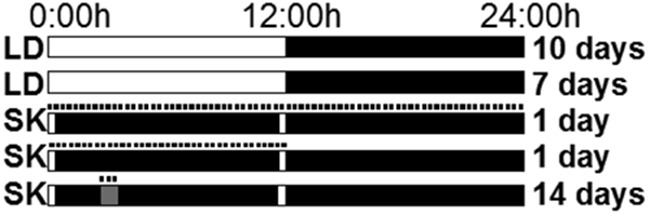

Schematic depicting experimental design. Mice were group-caged for 10 d and then housed singly for 7 d. The LD cycle (white bar = lights on, black bar = lights off) was used for the first 17 d to establish entrainment. For the remainder of the study, a skeleton photoperiod was used (lights on ZT0–ZT0:30 and ZT11:30–ZT12:00) to maintain entrainment. MA or W was nebulized in the chamber at either ZT4 (gray bar) or ZT10 (not shown in cartoon). Dashes, tunnel door from home cage to nebulizing chamber is open; SK, skeleton photoperiod.